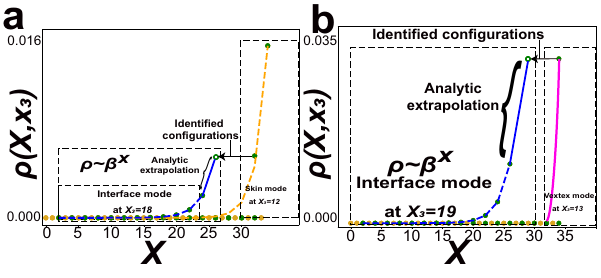
Fig. 8 Details of the discussion on the interface of the effective lattice for the subsection "Cluster states of topological origin" from the section “ Method ” . Identi fi ed con fi gurations from bosonic symmetry. a The yellow (cid:4) (cid:4) (cid:4) (cid:4) 2 curve: the skin mode of ρ ð X ; x 3 Þ ¼ Ψ ð X ; x 3 Þ ; The blue curve: the (cid:4) (cid:4) x 3 ¼ 12 (cid:4) (cid:4) 2 Þ ¼ Ψ ð X ; x Þ interface mode of ρ ð X ; x . The “ Identi fi ed con fi gurations ” 3 3 x 3 ¼ 18 between sites allows us to move a section (the dashed rectangle) of the skin mode to the nearest site of the interface mode (the green hollow circle). We perform an analytic extrapolation (blue solid line) according to the non-Bloch scaling controlled by β (the solid blue line) to link the two (cid:4) (cid:4) (cid:4) (cid:4) 2 ends. b The pink curve: the vertex mode of ρ ð X ; x 3 Þ ¼ Ψ ð X ; x 3 Þ ; The (cid:4) (cid:4) x 3 ¼ 13 (cid:4) (cid:4) 2 blue curve: the interface mode of ρ ð X ; x 3 Þ ¼ Ψ ð X ; x 3 Þ . Exponential x 3 ¼ 19 localizations as the blue and yellow curves follow the scaling ρ ( X , x 3 ) ~ β X with β = ( t 1 + γ )/( γ − t 2 ). In our model, bosonic symmetry leads to equivalent “ identi fi ed con fi gurations ” in the effective lattice in Fig. 1d, and hence skin cluster states on it that can be pieced together like a jigsaw- (cid:4) (cid:4) (cid:4) (cid:4) 2 represents the localization in puzzle. The density as ρ ð X ; x 3 Þ ¼ Ψ ð X ; x 3 Þ the graph in Fig. 2a for the 3-boson cluster under open boundary conditions (OBCs). Parameters for a and b are t 1 = 1.0, t 2 = 0.2, γ = 2.0, and L = Cluster states of topological origin . In our effective lattice for 3 bosons under OBCs from the main text, there exists both physical boundaries and effective interfaces as shown in Fig. 2a. When γ ≠ 0, localization occurs at both the two boundaries. Figure 7 presents the state amplitude distribution in the effective lattice of a selected OBC zero mode with t 1 = 1.2, t 2 = 0.2, γ = 0.5, L = 20. To show that the localizations near the interface and the physical boundary have the same topological origin, we perform the curve fi tting of these decays and compare the analytical result β = ( t 1 + γ )/( γ − t 2 ) (the solution of the effective non-Hermitian SSH model) with the curve fi tted results from numerical diagonalization of the 3-body system. Indeed, for the zero modes of the three-body sector, the decays at the physical boundary ( β 0 ) and effective interfaces ( β ″ ) all agree viz. β 00 ; β 0 (cid:3) β ( ρ ( x ) ≈ β x ).